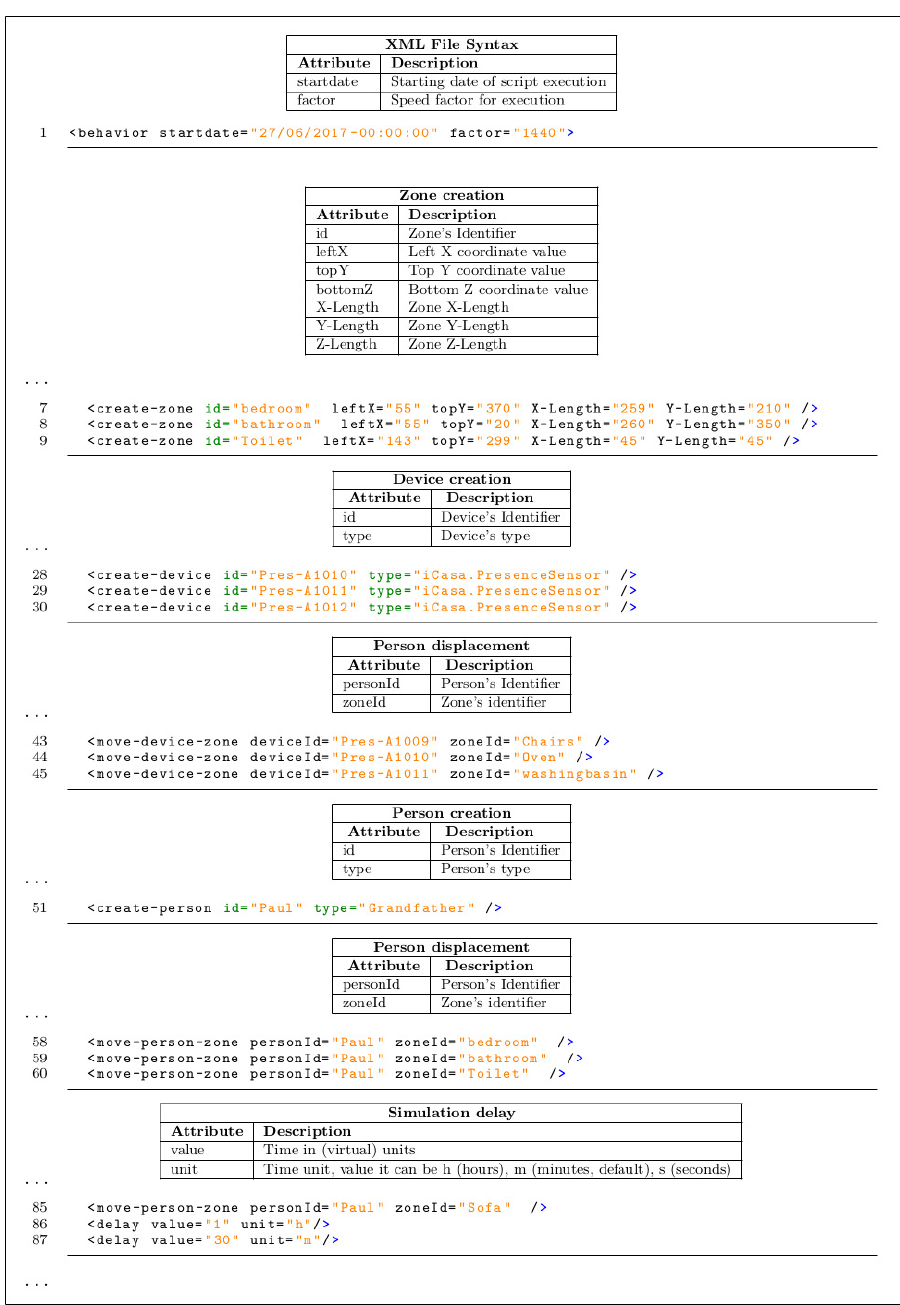
Figure 9. Excerpt of an XML format file scenario employed by the simulator